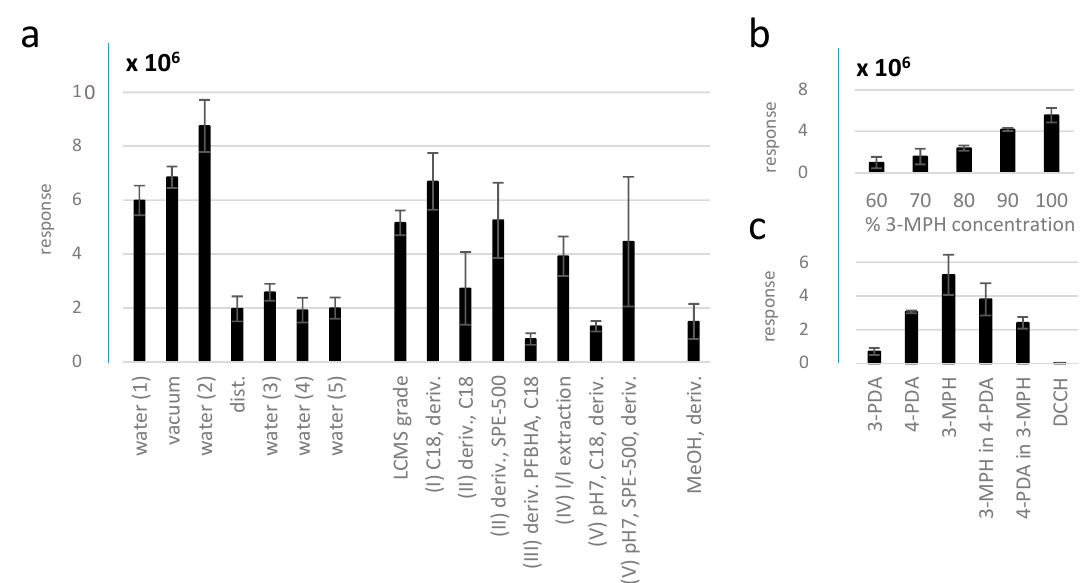
Figure 6. ( a ) Water contamination with MGO analyzed as MGO–dihydrazone after incubation with 3-MPH. Different quality laboratory water and different procedures for purification of water were tested, refer to Section 2.3. ( b ) Response of the MGO–dihydrazone in preparations containing different concentrations of 3-MPH in relation to the original 5 mM solution. ( c ) Response of the corresponding MGO derivatives in blank solutions of four different reagents and response of the dihydrazone after incubation of a 3-MPH solution with 4-PDA and the quinoxaline in a 4-PDA solution with 3-MPH.